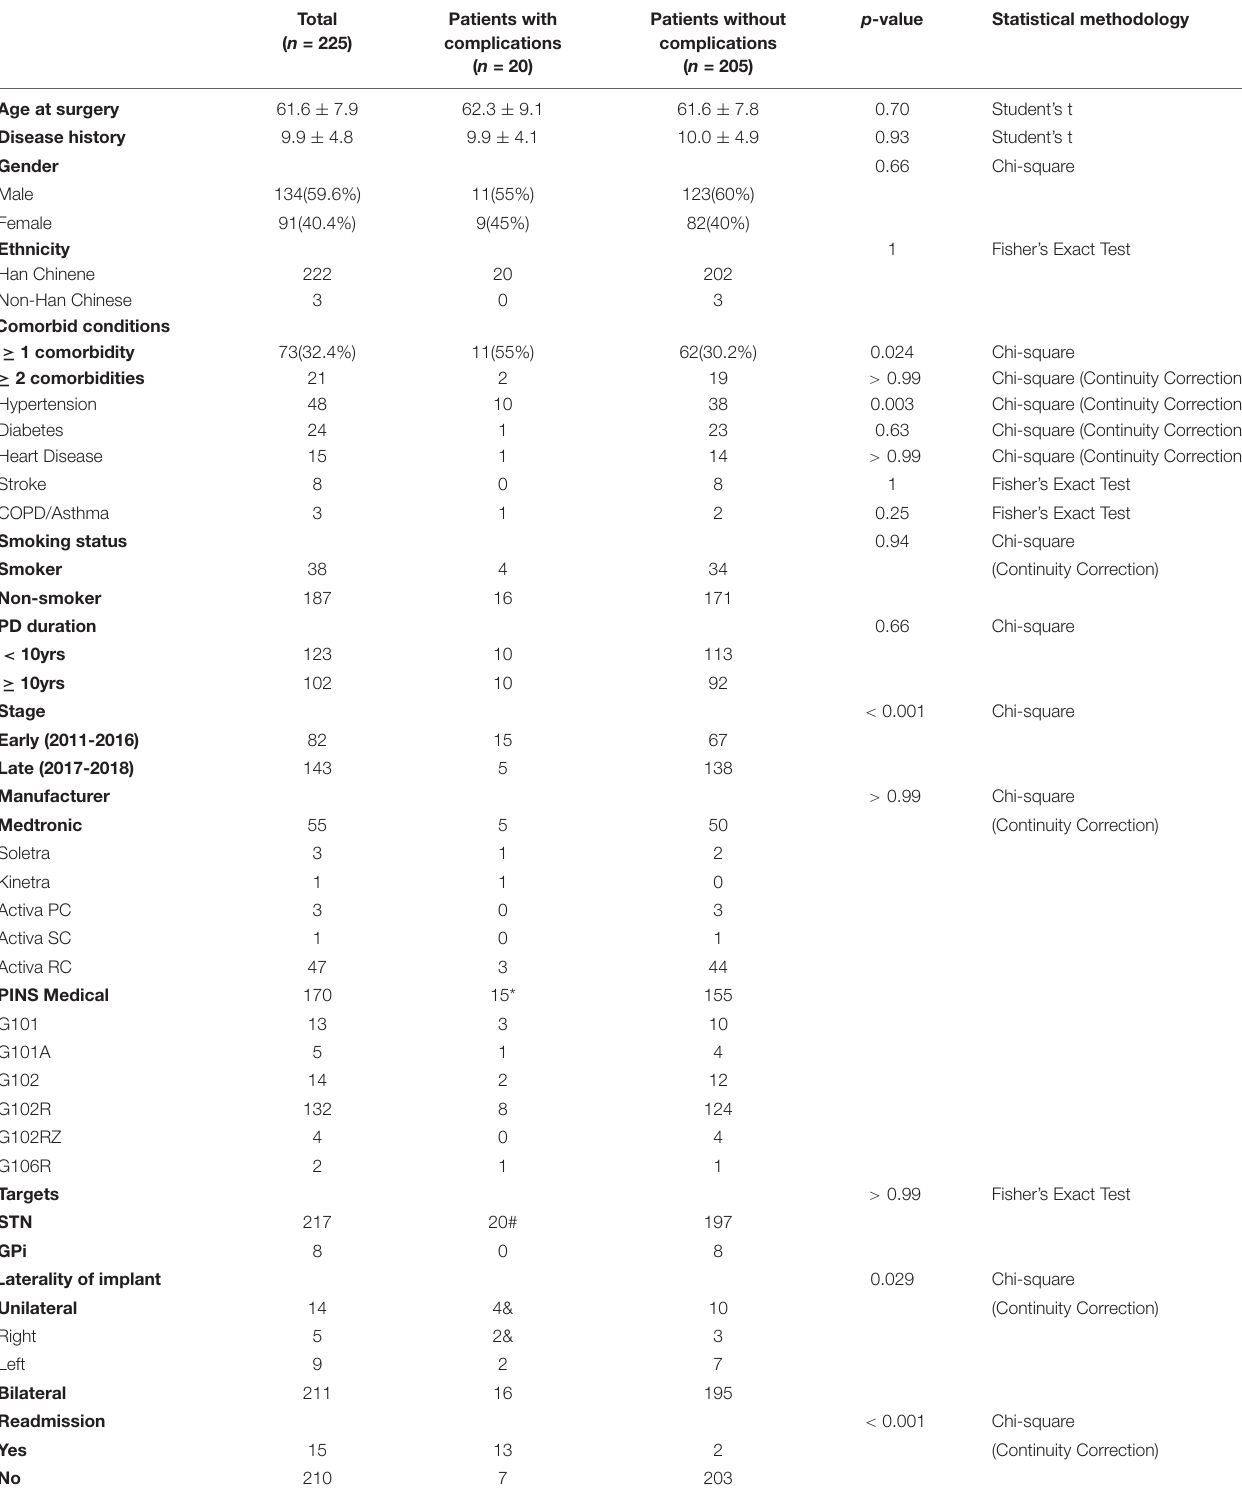
TABLE 1 | Demographics of Patients with Postoperative